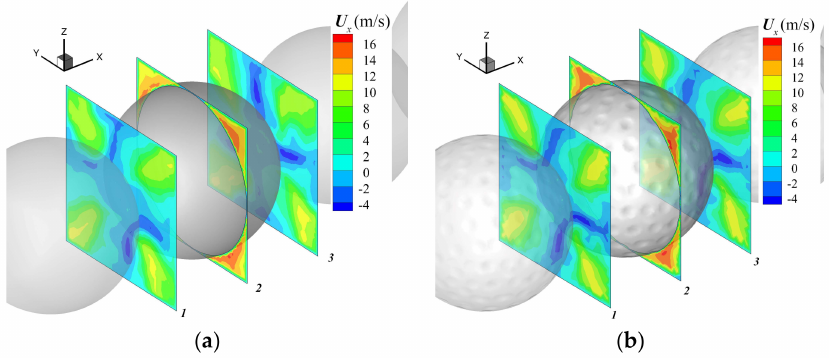
Figure 9. The streamwise velocity in the cross sections of ( a ) SPBS and ( b ) SPBD at N = 1.00 ( Re H =